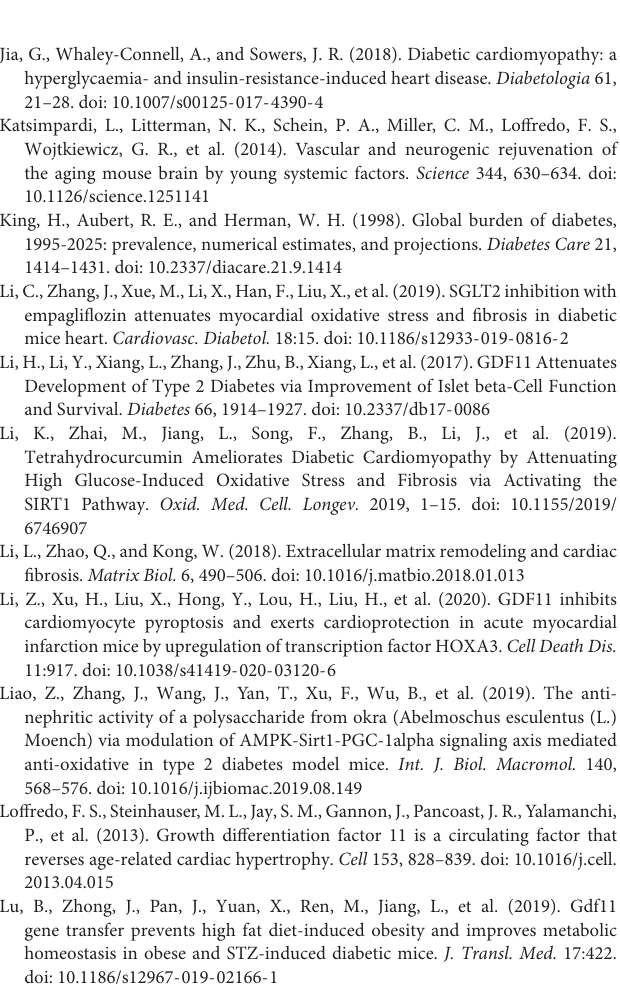
Supplementary Figure 1 | Successful establishment of the diabetic model. (A) Experimental flow graph. (B) Body weight. (C) Fasting blood glucose (FBG) after 2-week STZ injection. (D) Intraperitoneal glucose tolerance tests (IPGTTs). (E) Intraperitoneal insulin tolerance tests (IPITTs). Data are presented as the mean ± SEM, n = 5 per group. ** P < 0.01 versus the non-diabetic group. Supplementary Figure 2 | GDF11 overexpression was induced by AAV-GDF11 and Ad-GDF11 in myocardial tissues and H9c2 cells, respectively. (A) Representative images of GDF11 immunofluorescence in heart tissue. (B) Representative blot of GDF11. (C) Quantitative expression of GDF11. (D) Representative images of GDF11 immunofluorescence in H9c2 cells. (E) Representative blot of GDF11. (F) Quantitative expression of GDF11. Data are presented as the mean ± SEM, n = 5 per group. ** P < 0.01 versus the Con group, †† P < 0.01 versus the DM group. Supplementary Figure 3 | EX527 blunted the increases in the expression and activity of SIRT1 in myocardium after GDF11 overexpression. (A) Representative images of SIRT1 immunofluorescence in heart tissue. (B) The deacetylase activity of SIRT1. Data are presented as the mean ± SEM, n = 5 or 6 per group. ** P < 0.01 versus the DM group, †† P < 0.01 versus the DM + AAV-GDF11 group. Supplementary Figure 4 | The expression and activity of SIRT1 were inhibited by SIRT1 siRNA in H9c2 cells. (A) Representative images of SIRT1 immunofluorescence in H9c2 cells. (B) Representative blot of SIRT1. (C) The deacetylase activity of SIRT1 in H9c2 cells. Data are presented as the mean ± SEM, n = 5 or 6 per group. ** P < 0.01 versus the Scramble siRNA